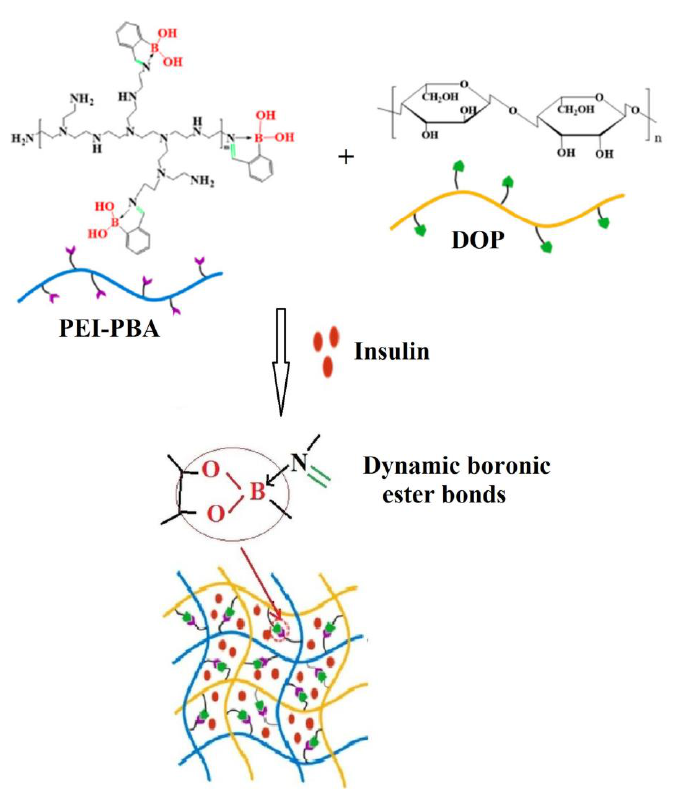
Figure 14. Schematic illustration of DOP/PEI-PBA hydrogel as insulin delivery system (Adapted from reference [102]. Copyright © 2023 by Liu, W. et al.).